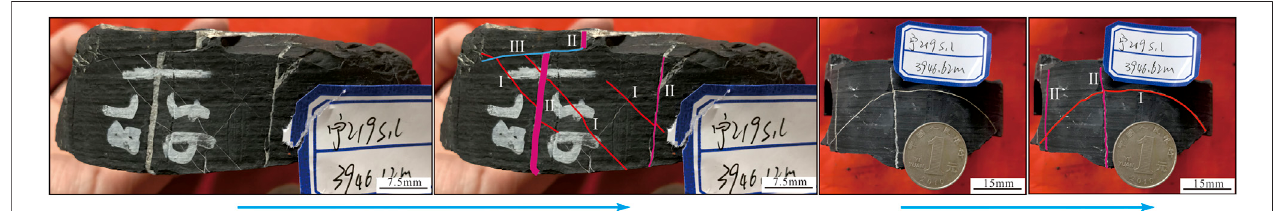
FIGURE 5 | Developmental characteristics and intersection relationship of core